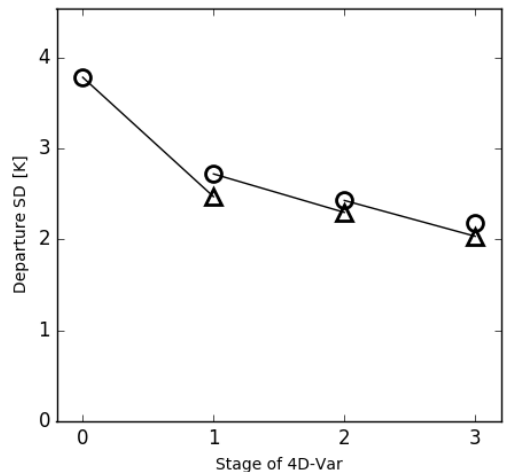
Figure 3. Standard deviation of departures for AMSR-2 channel 10 in the nonlinear trajectories (circles) and at the end of the min- imisation of the linearised cost function (triangles) for each outer loop of 4D-Var. Note how the nonlinear and linearised departure standard deviations should coincide in the linear case. The average background error standard deviation in observation space for this type of observation is 3.4K. Results from a single cycle from the ECMWF operational assimilation system.